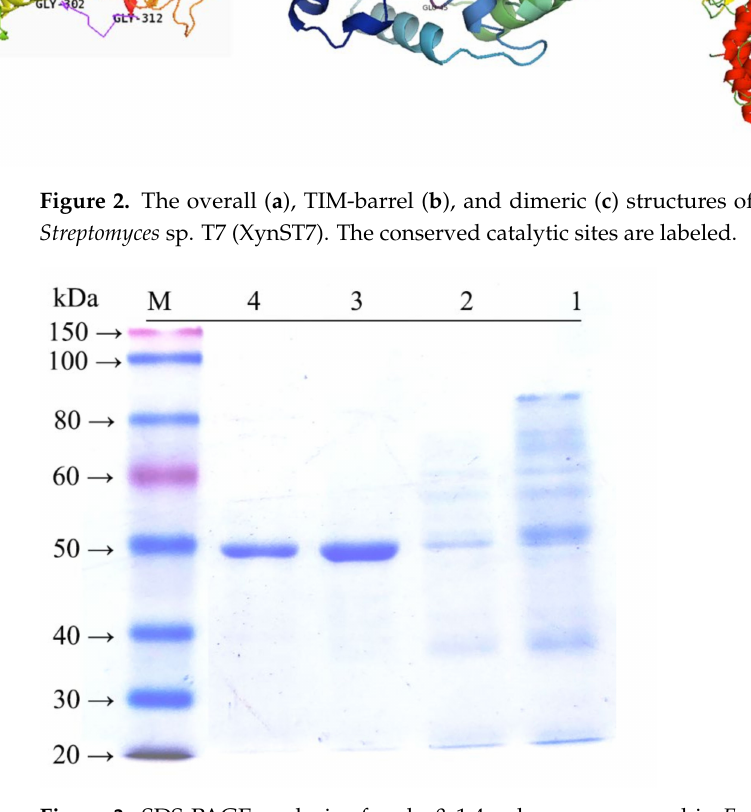
Figure 3. SDS-PAGE analysis of endo- β -1,4-xylanase expressed in E. coli BL21 (DE3). Lanes: M, protein molecular weight marker; 1, crude enzyme after ultrasonication; 2, Eluted fraction with 10 mM imidazole buffer; 3, Eluted fraction with 100 mM imidazole buffer; 4, purified fraction after